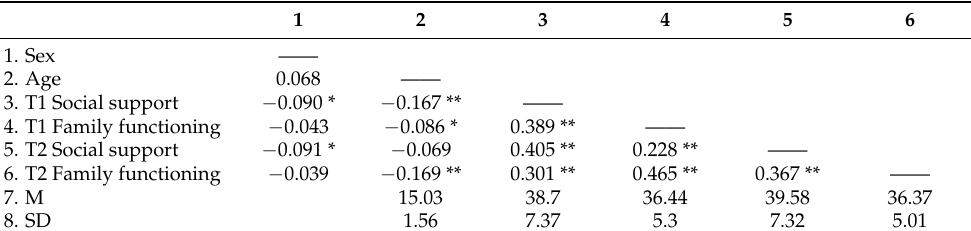
Table 2. Descriptive and correlation